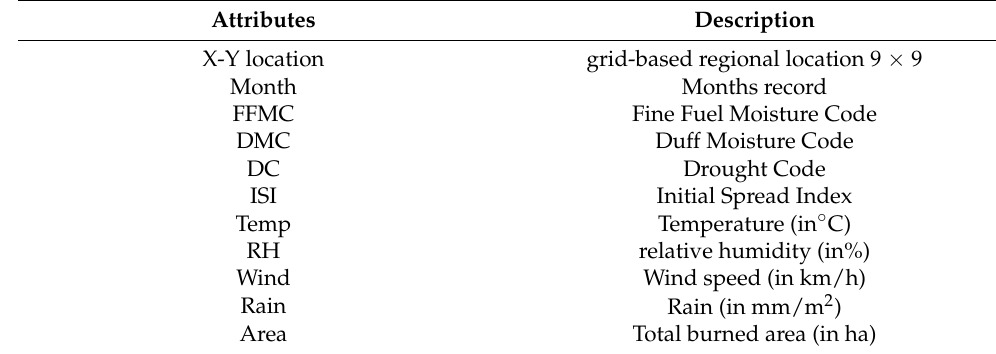
Table 3. The attributes of Montesinho Natural Park forest fire data [3].